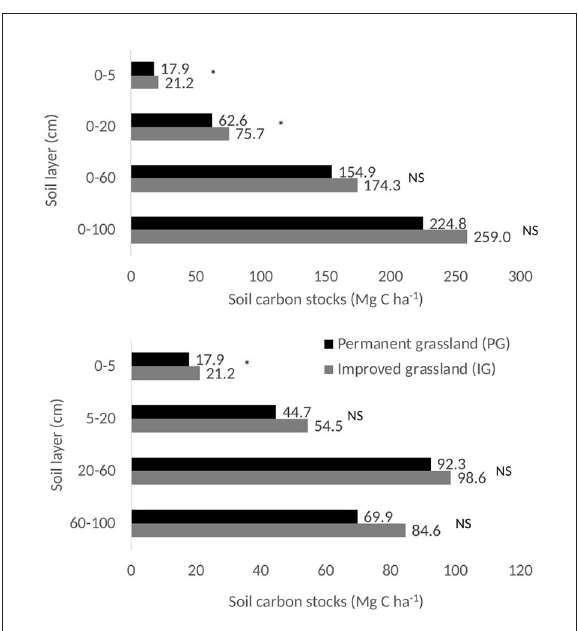
FIGURE3 Soil carbon stocks (Mg C ha − 1 ) of soil layers in two grassland areas at Hacienda San Jose, Colombia. Asterisk (*) represent significant differences according to the Tukey HSD test at 5% level. NS,